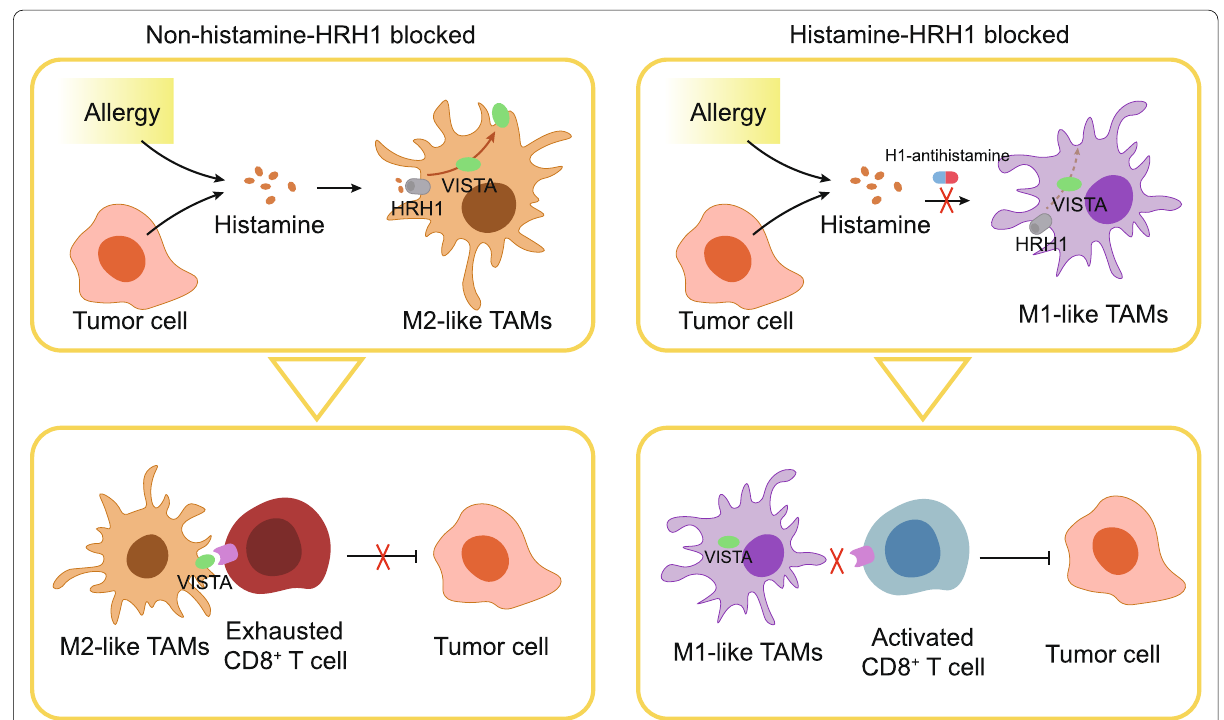
Fig. 1 The impact of Histamine binding to macrophages histamine receptor H1 (HRH1) on the tumor microenvironment. Tumor-derived or allergy-released histamine bind to HRH1 educating macrophages toward the M2 activation status and promoting V-domain Ig suppressor of T cell activation (VISTA) membrane localization. Conversely, blocking HRH1 elicit the polarization of M1 macrophages and reduce the expression of VISTA in the cell membrane, promoting CD8 + T cell function and inhibiting tumor growth. TAMs, tumor-associated